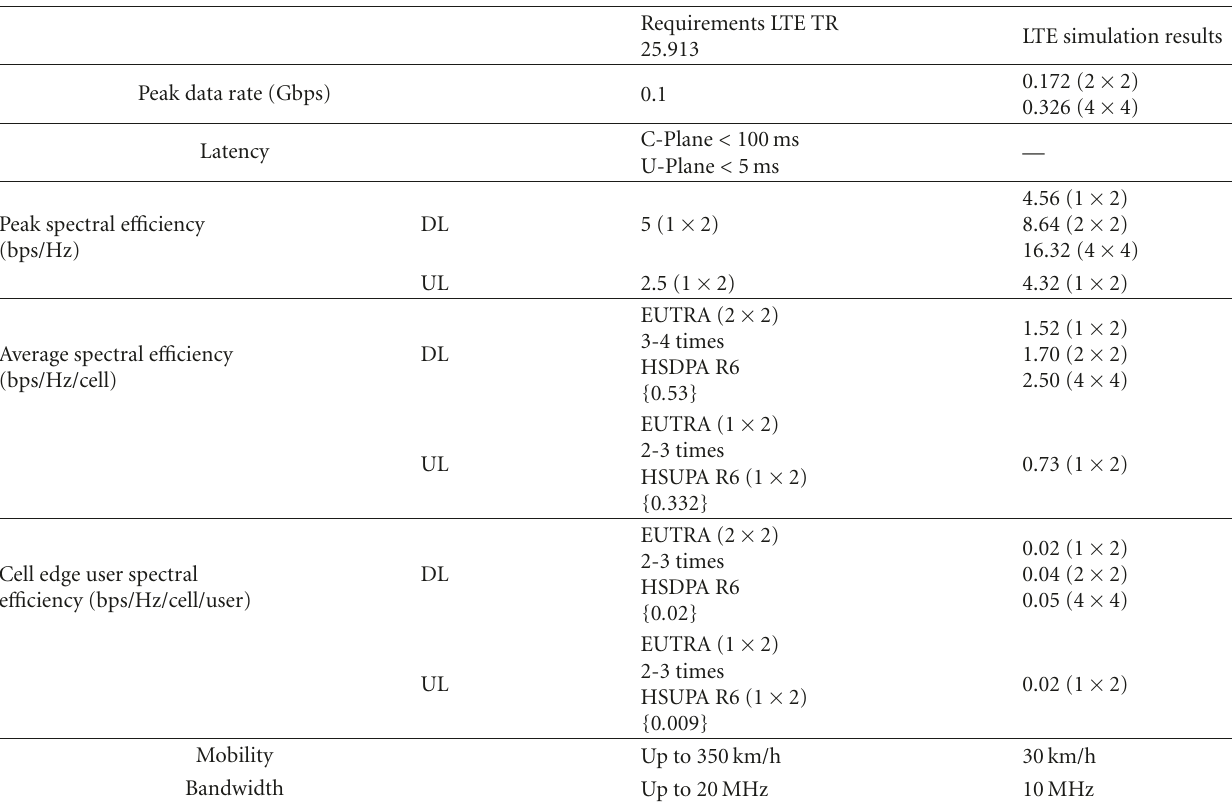
Table 2: LTE requirements related to technical performance.